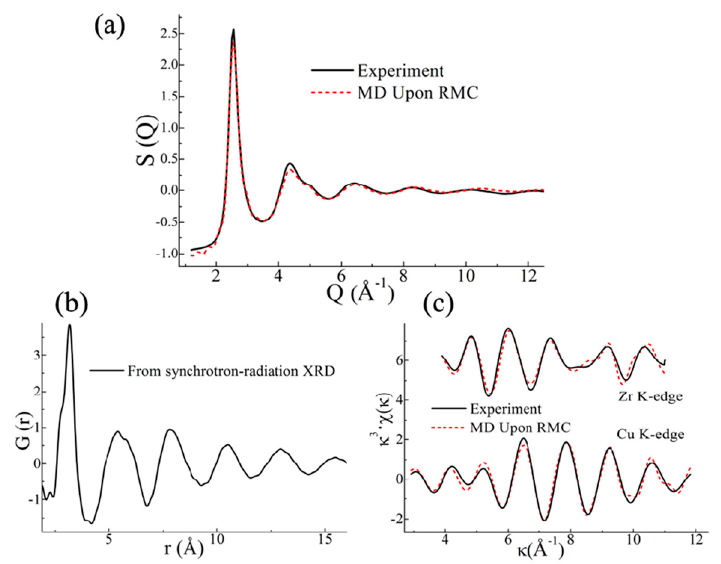
Figure 1. (Color online) Structural signals, including: ( a ) Structure factor, S (Q); ( b ) total pair distribution function, G (r); ( c ) Zr and Cu K-edge EXAFS (extended X-ray absorption fine structure) spectra. The solid and the dashed lines denote experimental and theoretical data, respectively. κ and χ ( κ ) represent the photoelectron wave vector and the κ -space EXAFS signal, respectively. This simulation was performed by MD (molecular dynamics) simulation to modify the RMC (reverse-Monte Carlo) initial model.